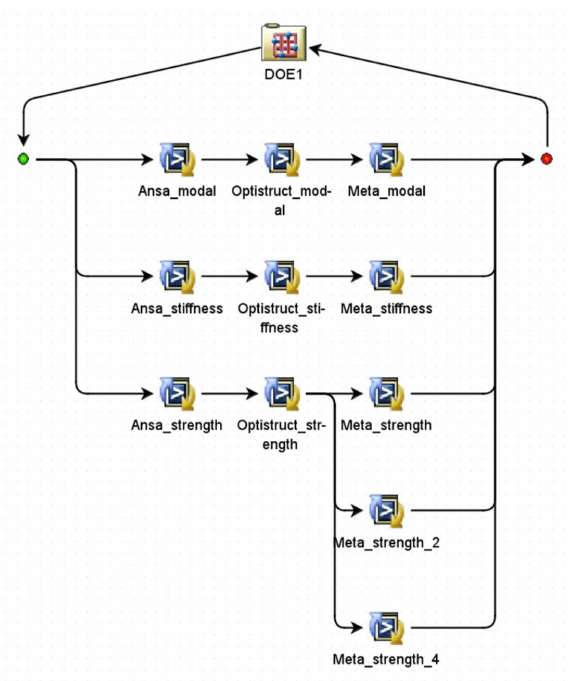
Figure 9. Multi-objective experimental design optimization